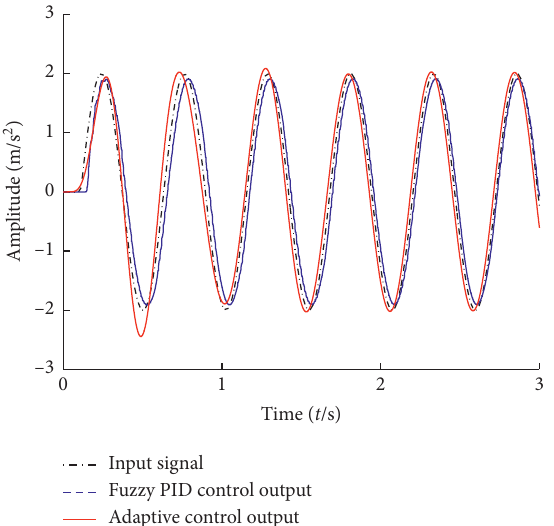
Figure 12: Signal comparison before and after control.